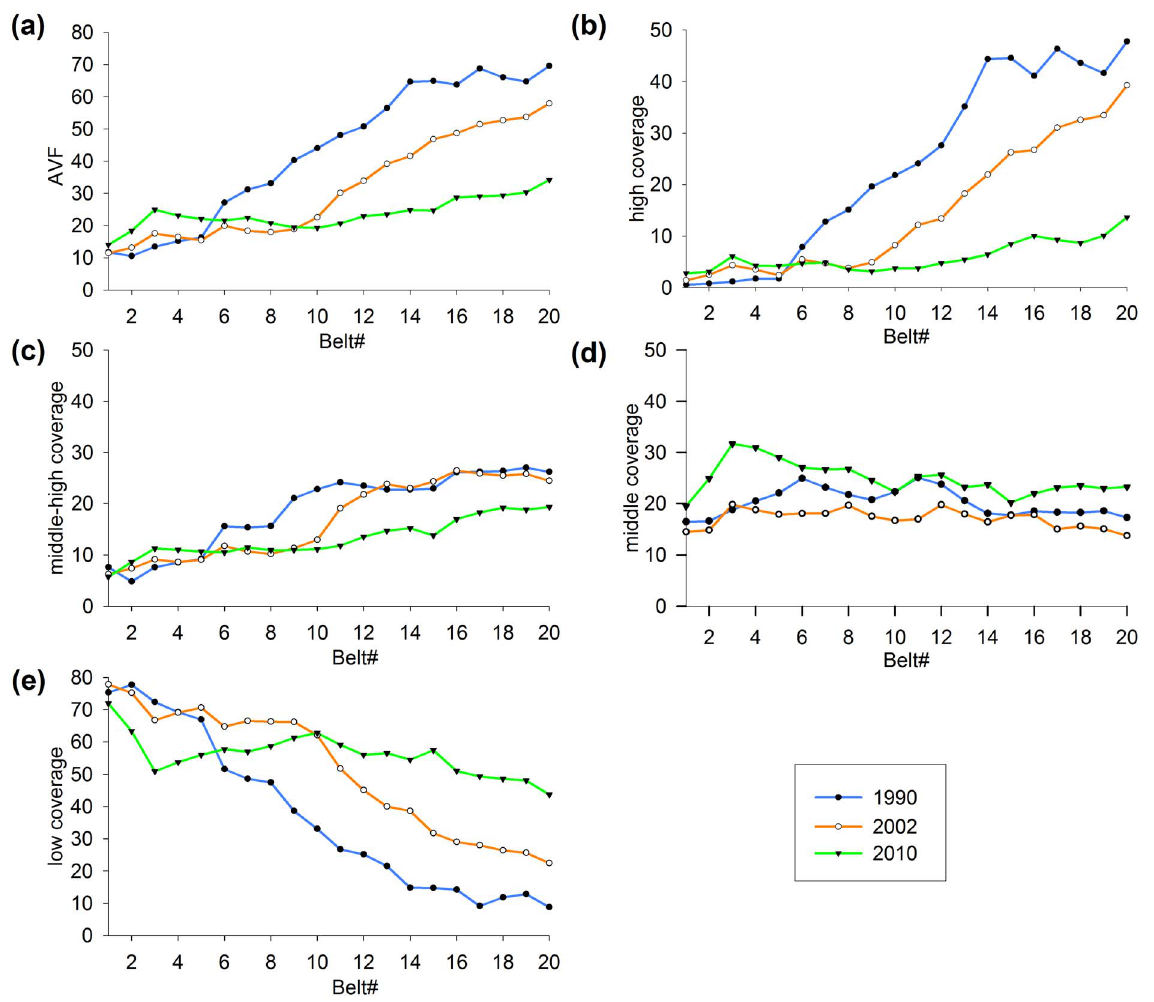
Figure 7. Concentric vegetation coverage analysis in each belt for each year. (a) Average vegetation fraction (AVF), (b) percentage of area of high coverage pixels, (c) percentage of area of middle-high coverage pixels, (d) percentage of area of middle coverage pixels, and (e) percentage of area of low coverage pixels.